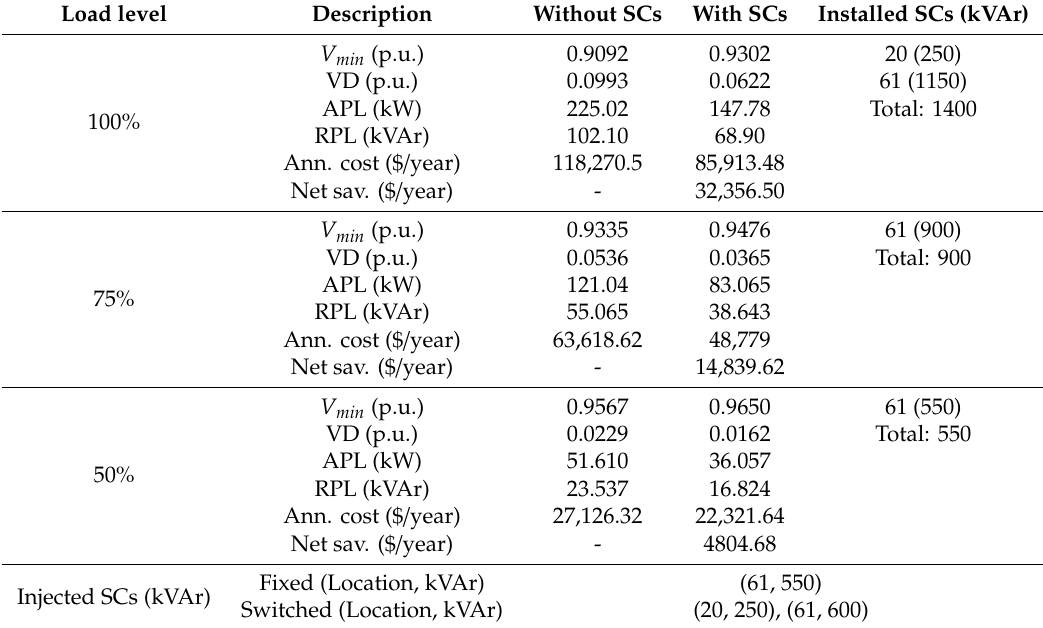
Table 5. Optimal results of PODESCA for the 69-bus system considering di ff erent load levels.